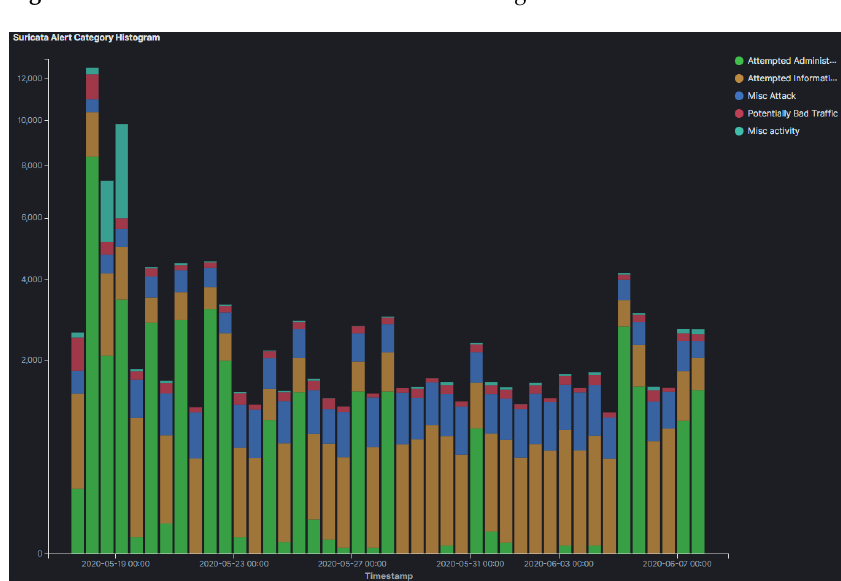
Figure 4. AWS Suricata Alert Category Histogram.